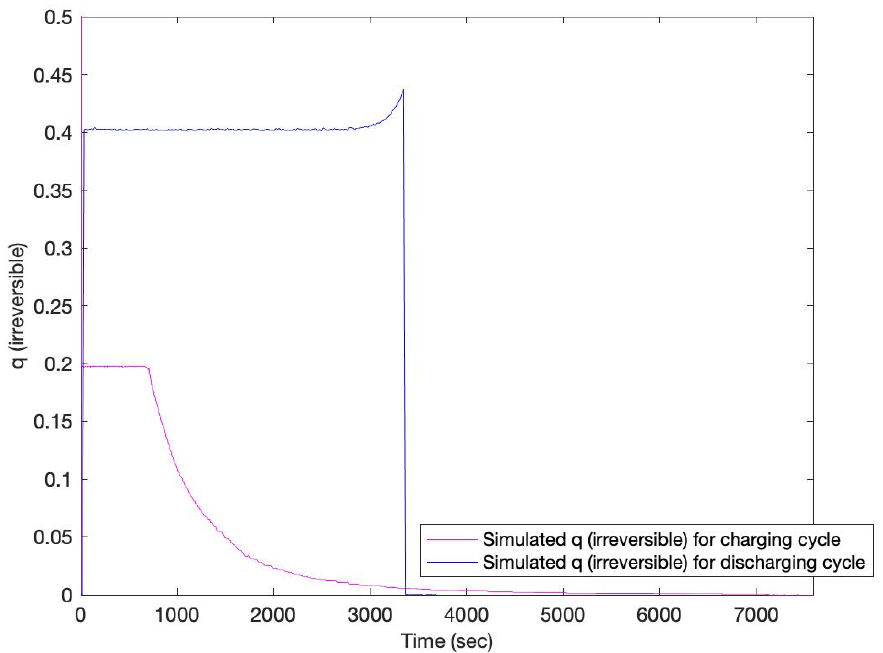
Figure 8. The simulated irreversible ohmic heating during charging/discharging cycles.